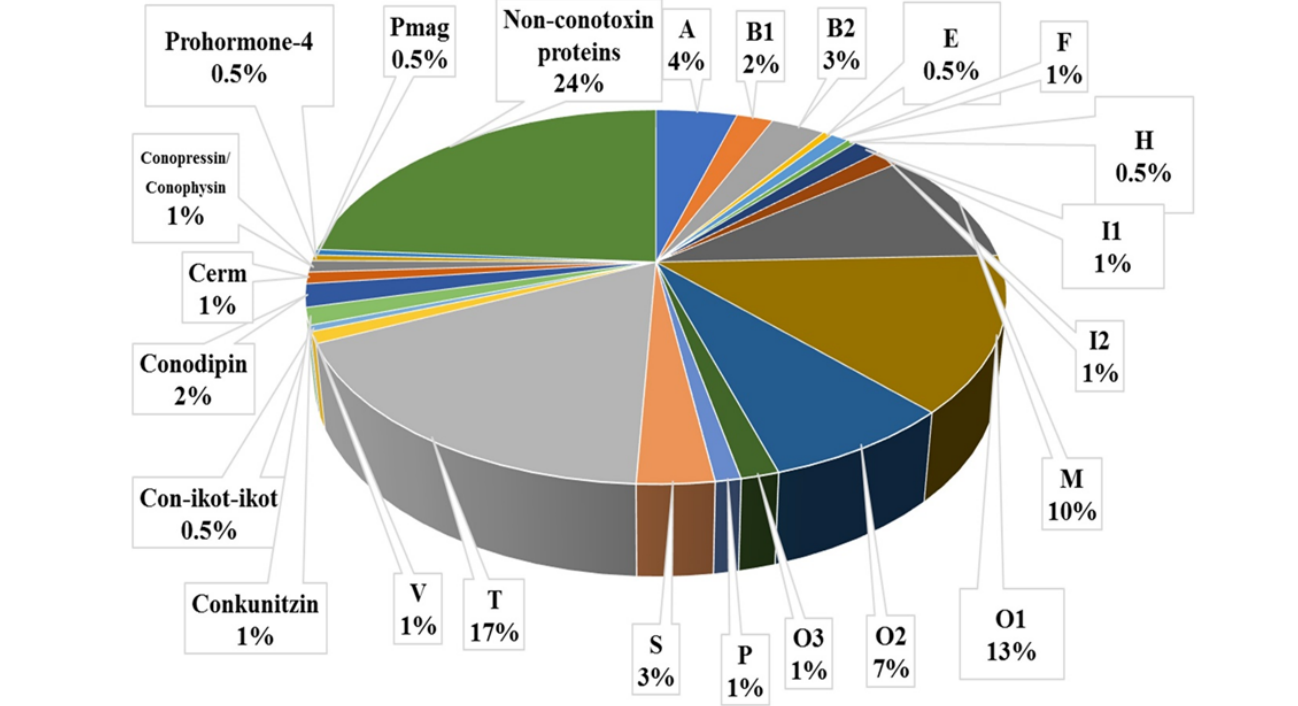
Figure 5. Percentage composition of conotoxin superfamilies and non-conotoxin proteins in C. taeniatus venom